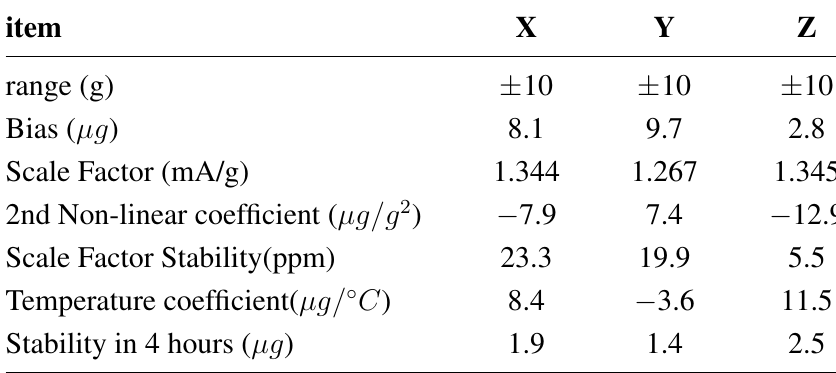
Table 2. The performance of the